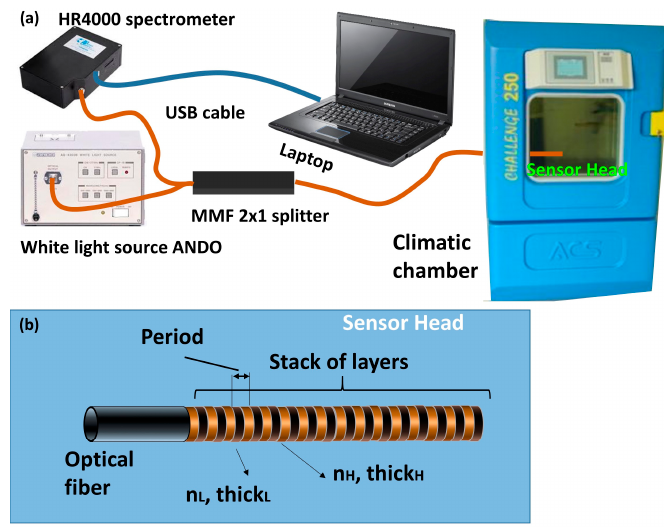
Figure 2. ( a ) Experimental setup for the characterization of the OFHS, and ( b ) a representation of the sensor head.